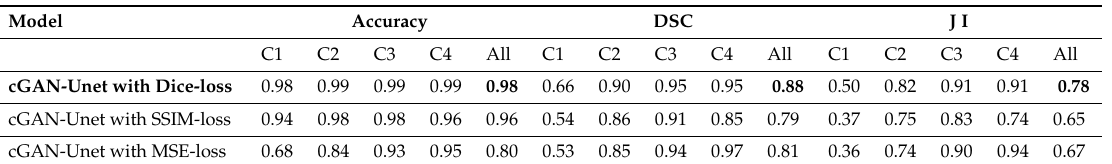
Table 2. Accuracy, DSC , and J I with the cGAN-UNet, cGAN-UNet-SSIM-loss, and cGAN-UNet-dice-loss evaluated on the testing set of the INBreast dataset for breast density segmentation (C1 = Class1, C2 = Class2, C3 = Class3, C4 =